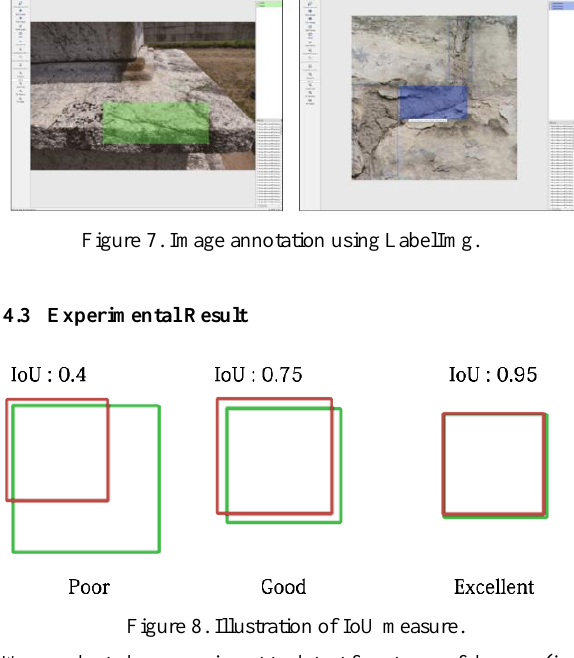
Figure 8. Illustration of IoU measure.